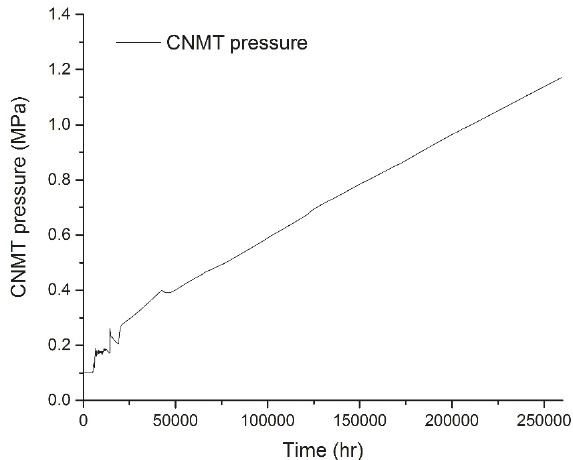
Figure 6: CNMT pressure in the base case